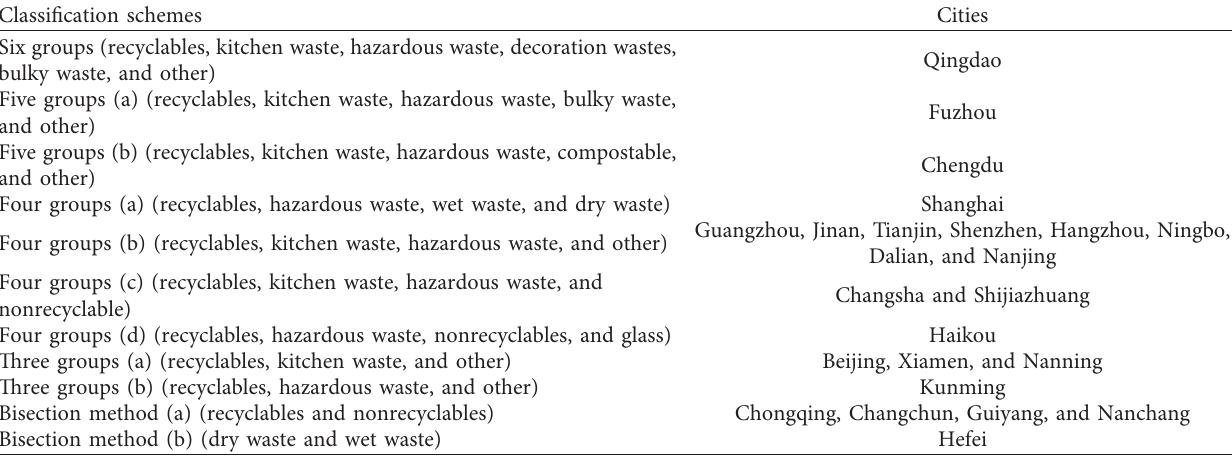
Table 1: MSW classification schemes in China.